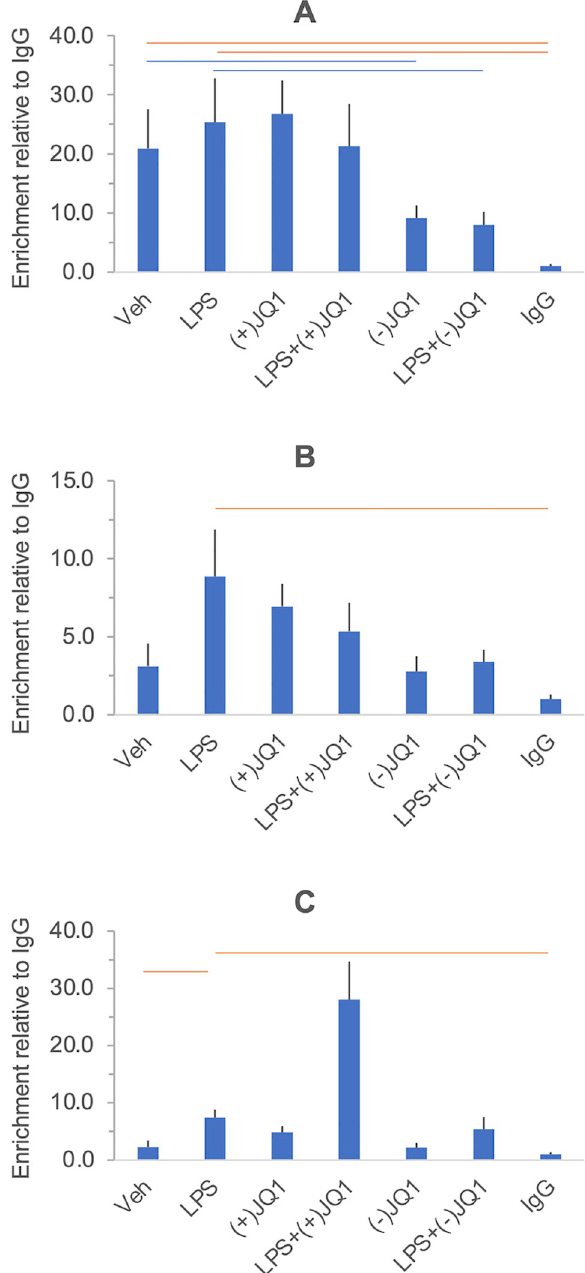
Fig 10. The effects of LPS, (+)-JQ1 and (-)-JQ1 on histone 4 acetylation at the IL6 (Panel A) CXCL8/IL8 (Panel B) and TNF (Panel C) promoters in DSCs. Primary cultures of DSCs were treated with vehicle, LPS, (+)-JQ1, (-)-JQ1, and their combinations indicated under the columns. Chromatin immunoprecipitation (ChIP) was performed using a pan-acetyl histone 4 antibody (S2 Table), and the results were expressed relative to the negative control IgG. Further details of the experimental procedures and the data processing are described in the legend of Fig 7. Columns show the mean ± SEM, n = 5–6 independent experiments. Significant differences (at 5% FDR), highlighted in the heatmap in Fig 9, are indicated by the horizontal orange and blue lines. The results of the individual experiments and summary statistics are presented in the S1